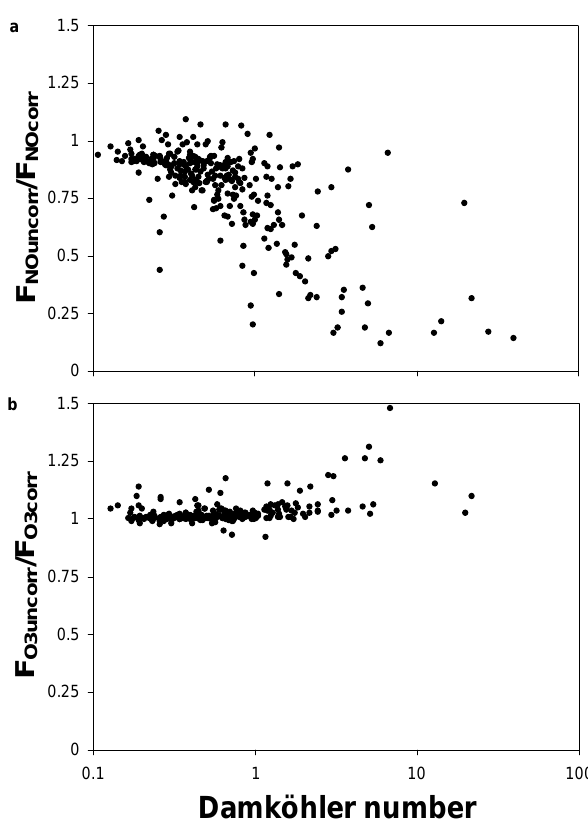
Figure 6: Ratio of fluxes without to fluxes with chemical corrections as a function of the Damköhler number for (a) NO and (b) O 3 .